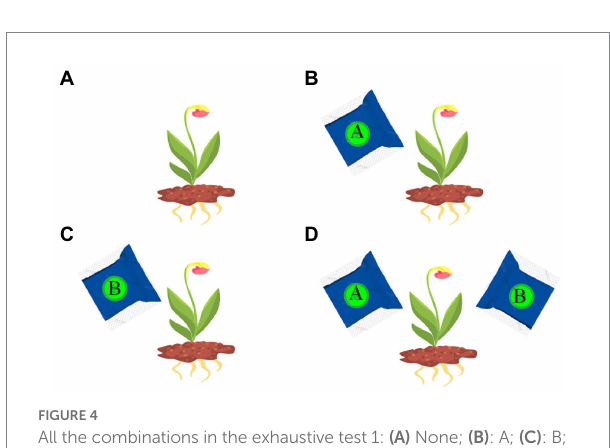
FIGURE 4 All the combinations in the exhaustive test 1: (A) None; (B) : A; (C) : B; (D) : A + B.